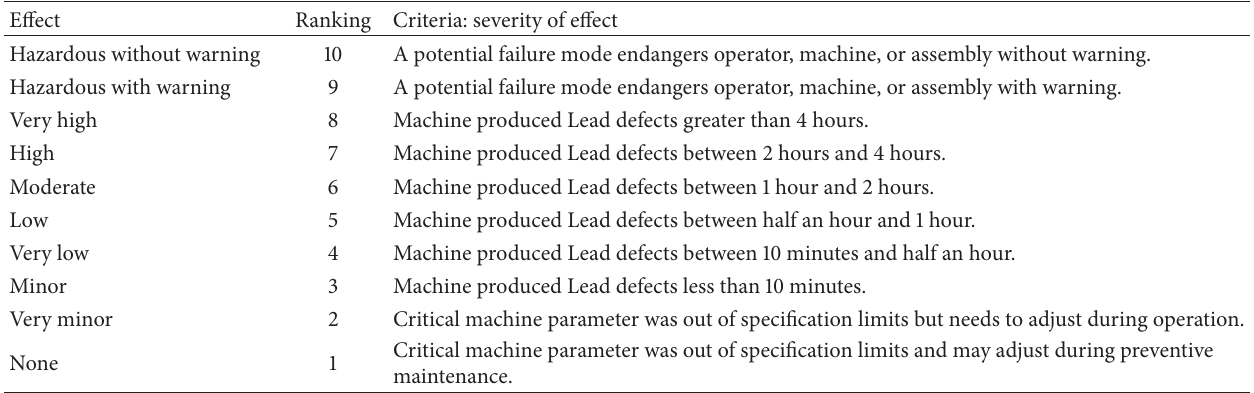
Table 1: Severity evaluation criteria.